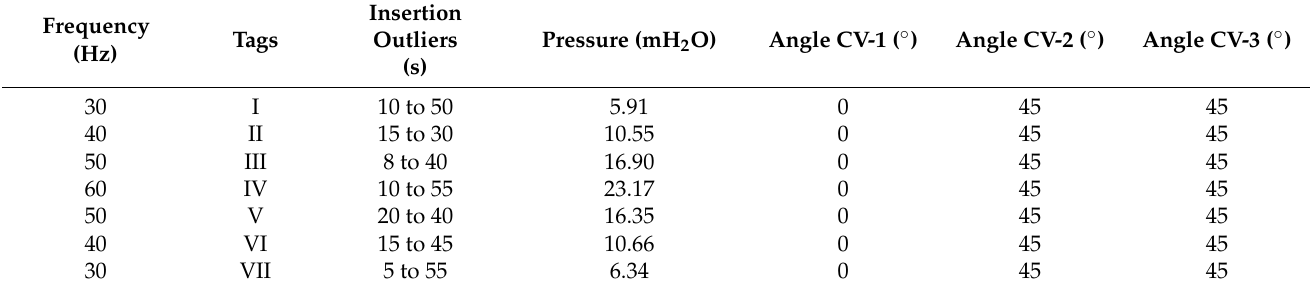
Table 4. Parameters used for the test of the soft sensor validation: testing